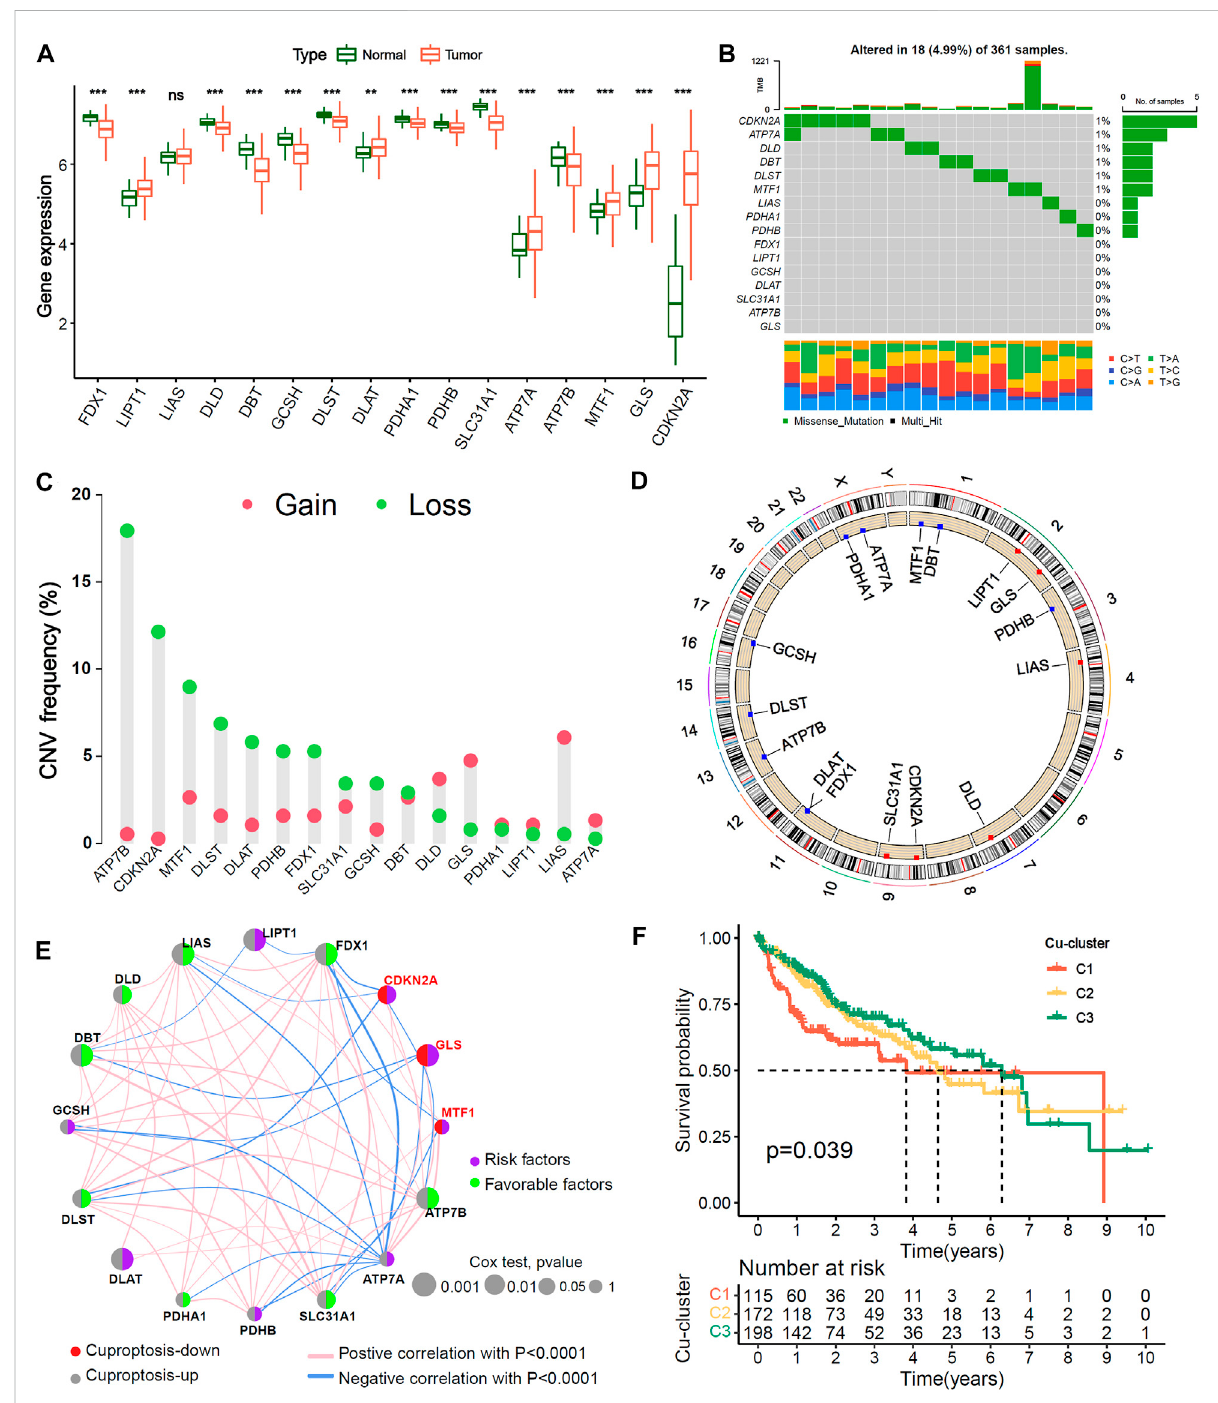
FIGURE 1 Genetic variation landscape and Unsupervised clustering of 16 Cu-RGs in HCC. (A) Comparison of 16 Cuproptosis-related genes (Cu-RGs) between normal and HCC tissues in mRNA expression. (B) The mutation frequency and classi fi cation of 16 Cu-RGs in TCGA-LIHC cohort. (C) The CNV variation frequency of16 Cu-RGs in TCGA-LIHC cohort. (D) The location of CNV alteration of16 Cu-RGs on the chromosomes in TCGA-LIHC. (E) Co-expression and prognosis relationship of 16 Cu-RGs in TCGA-LIHC. The regulation of Cu-RGs to cuproptosis were depicted by circles (lift) intwo colors: red,cuproptosis-down; gray,cuproptosis-up. The lines connecting 16 Cu-RGs represented their interaction with eachother.The size of each circle represented the prognosis effect of each regulator and scaled by p -value. The color on the right half of the circle represents the effect of Cu-RGs on prognosis: green, protective factors; purple, risk factors. (F) Kaplan-Meier curves of overall survival (OS) for 485 HCC patients in TCGA-GEO cohort with different Cuproptosis-clusters (termed as C1, C2 and C3). The numbers of patients in C1, C2, and C3 are 115, 172, and 198,